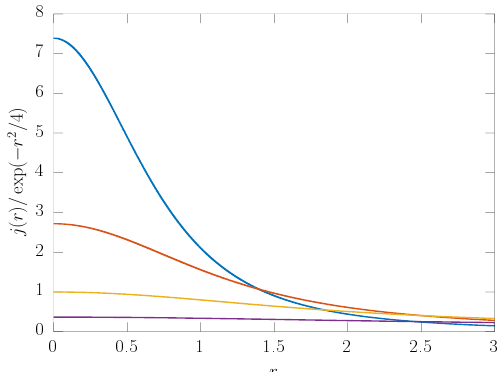
Figure 4. Influence of the presence of the non-zero γ z in the profile. We can see that as soon as φ ( 0 ) > 0, we end up with a better radial confinement of the plasma. We consider the solutions of Equation (12) with the plus sign. Initial conditions are φ ( 0 ) = 2 (blue), φ ( 0 ) = 1(orange), φ ( 0 ) = 0 (yellow) and φ ( 0 ) = 1 (magenta). −